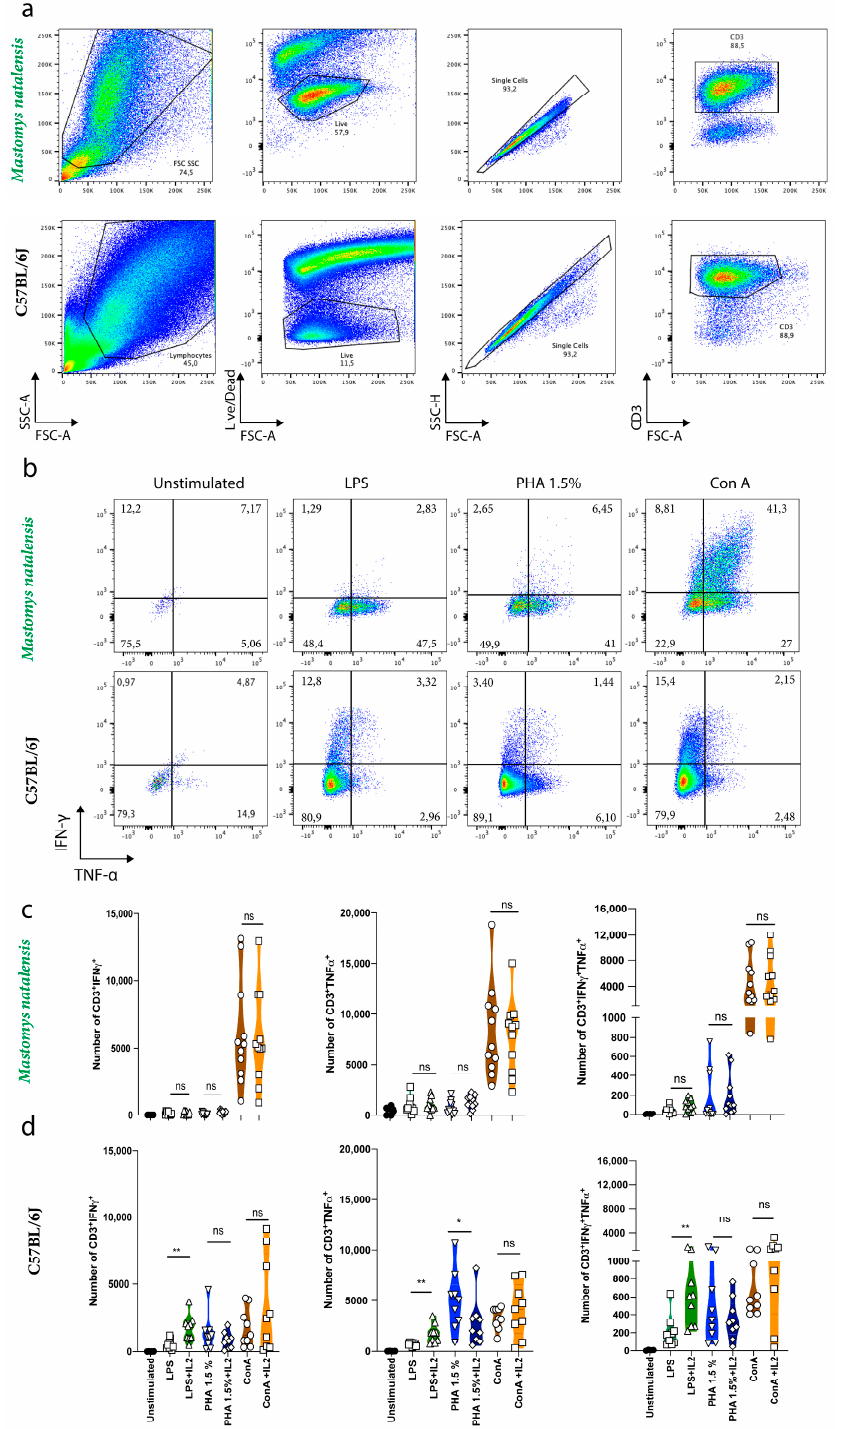
Figure 3. Expression of intracellular cytokines in response to different stimuli. Exemplary gating strategies defining the investigated CD3 + T cell population of M. natalensis and C57BL/6J are shown in the upper and bottom portion of graph a, respectively ( a ); Representative flow cytometry plots of splenic cells derived from M. natalensis (upper part) or C57BL/6J mice (bottom part, used as a positive control) stimulated with LPS, PHA, or ConA for 6 days followed by 6h stimulation with PMA/Ionomycin and BFA ( b ); Expression of TNF- α and IFN- γ were assessed by intracellular staining ( b ); Number of CD3 + T cells expressing effector molecules by M. natalensis ( c ); and C57BL/6J ( d ) is shown. Symbols represent individual animal. N = 12 M. natalensis and N = 9 C57BL/6J mice of two independent experiments ( c , d ). ns: not significant; * p < 0.01; ** p < 0.001; One-way